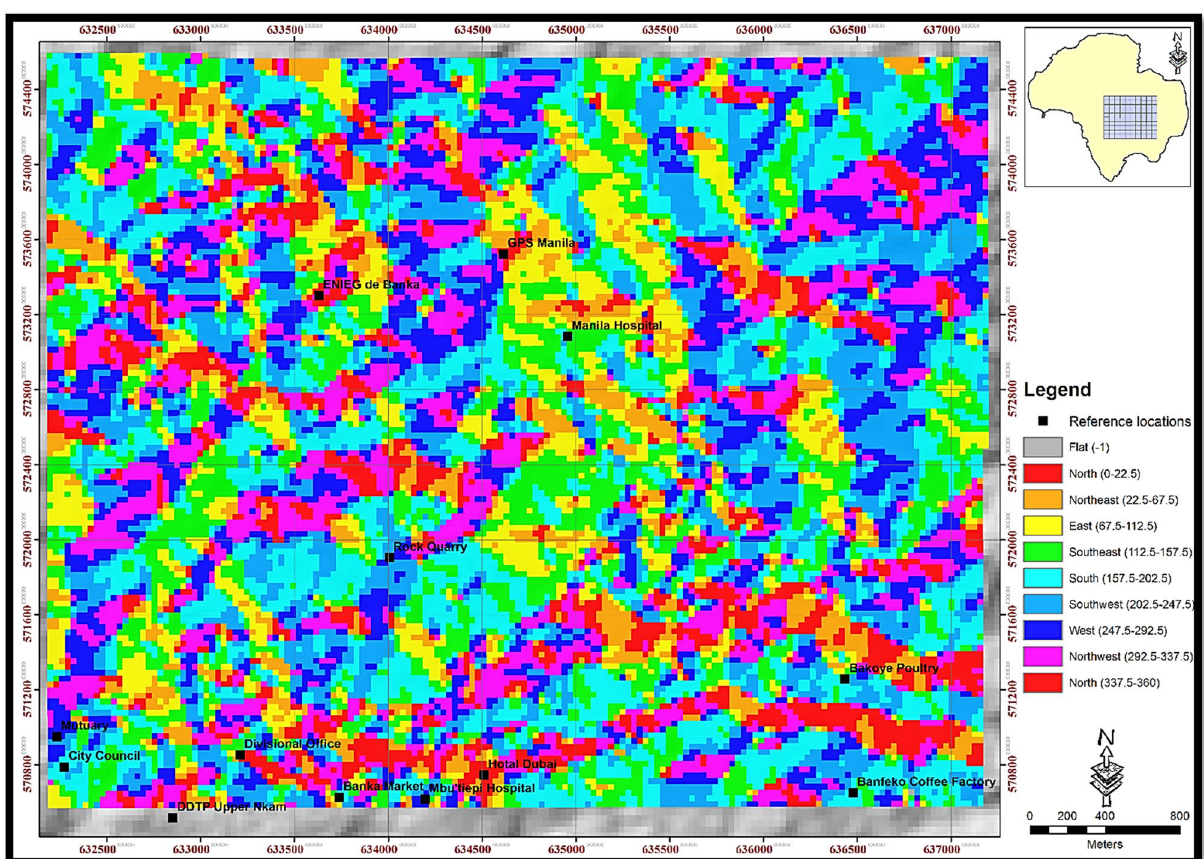
Fig. 11 Aspect map of study